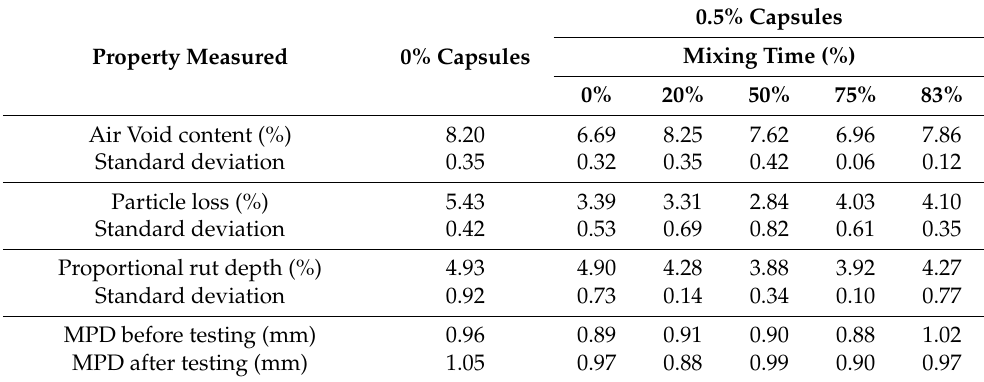
Table 6. Testing of lab asphalt mixtures varying the mixing process on asphalt containing cellular cap-